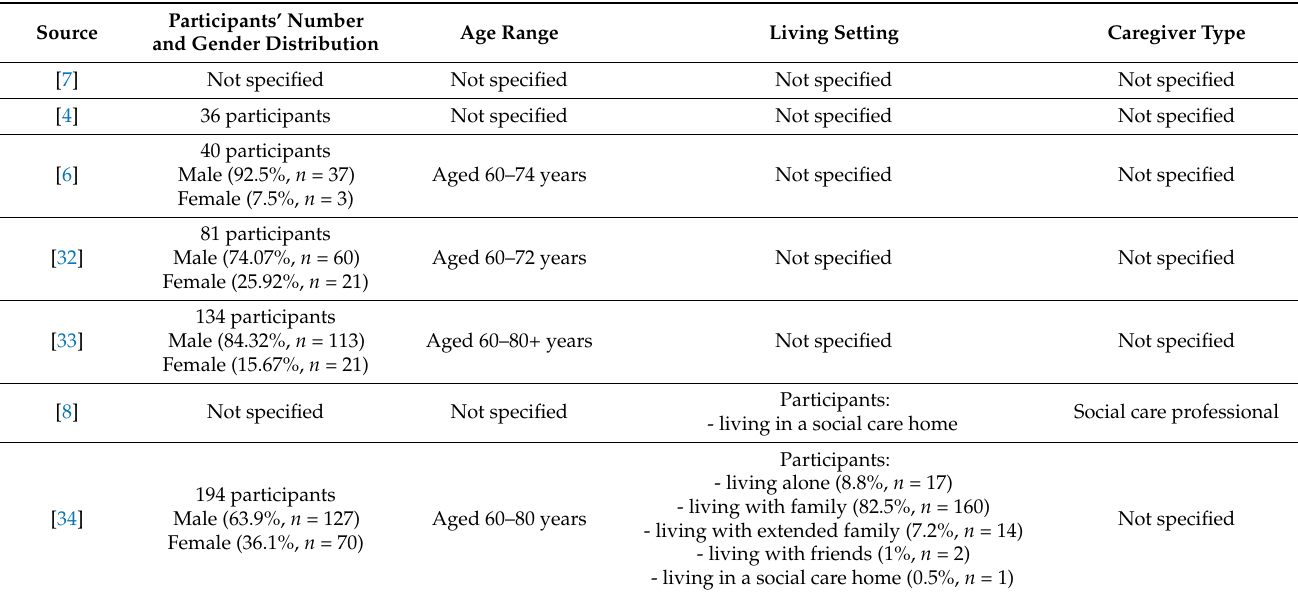
Table 3. Demographics of the